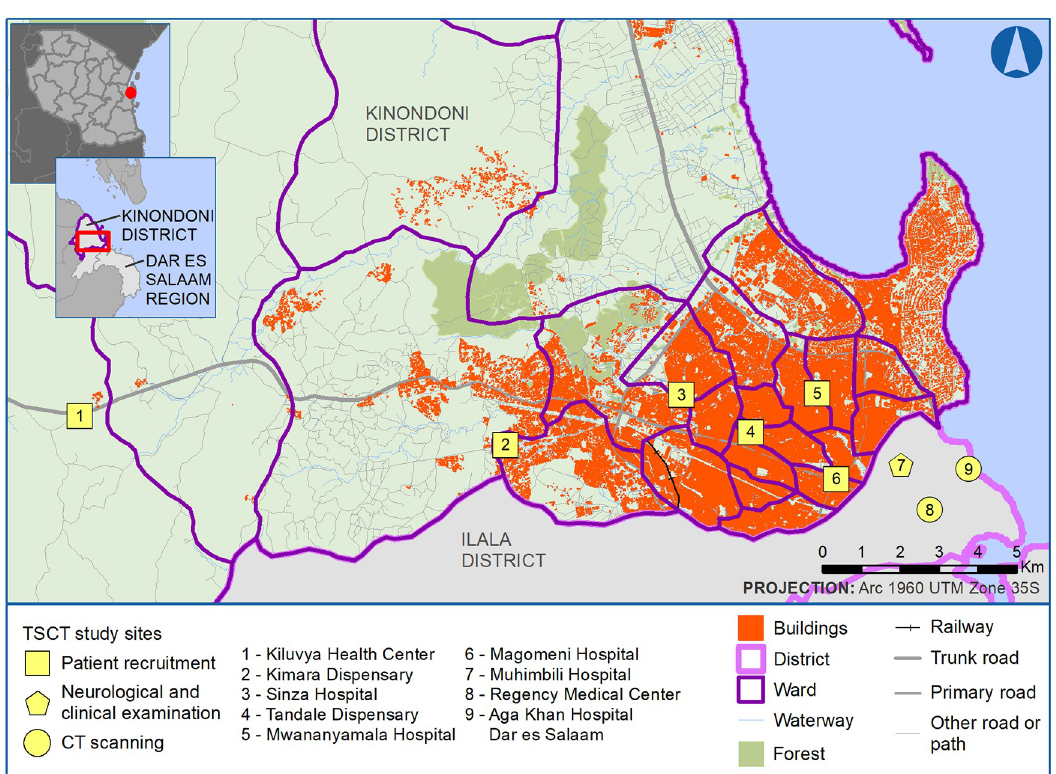
Fig 1. Location of recruitment centers with the distribution of urban and peri-urban areas. Buildings, roads, railways, waterways, and forest data are copyrighted by OpenStreetMap contributors and available from https://www.openstreetmap.org (OpenStreetMap contributors (2016) Planet Dump [Data file from 2016 Aug. 18]). Extract retrieved 2016 Aug. 23 from BBBike, https://download. bbbike.org/osm/). Country, region, district, and ward boundaries are from the GADM database of Global Administrative Areas, v2.8 (November